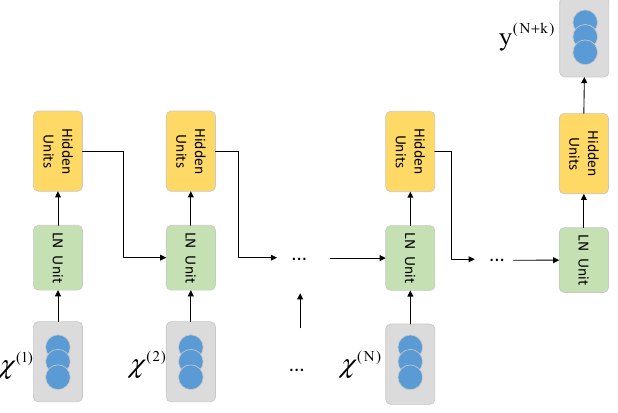
Figure 2. The architecture of the OR-ELM model.